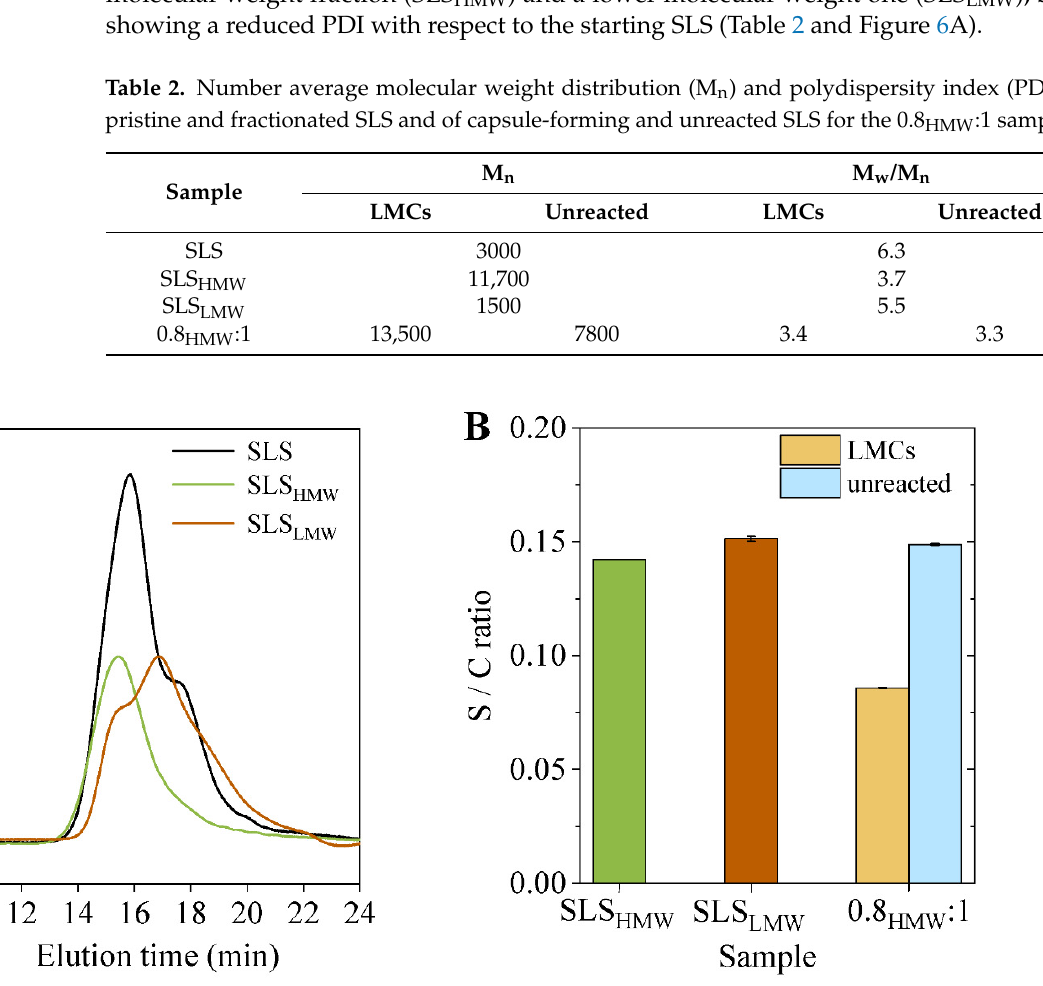
Figure 6. ( A ) GPC elugrams of fractionated SLS (SLS HMW and SLS LMW ) as compared to pristine SLS; ( B ) S/C ratio for fractionated SLS and for capsule-forming and unreacted lignin in LMCs produced from SLS HMW .